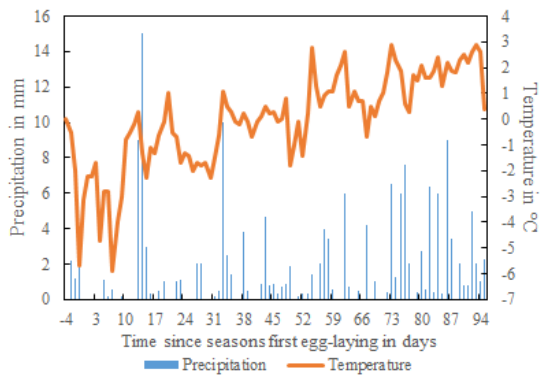
Figure 13. Season 2017/18: precipitation and temperature. Source: rp5.ru (2018)